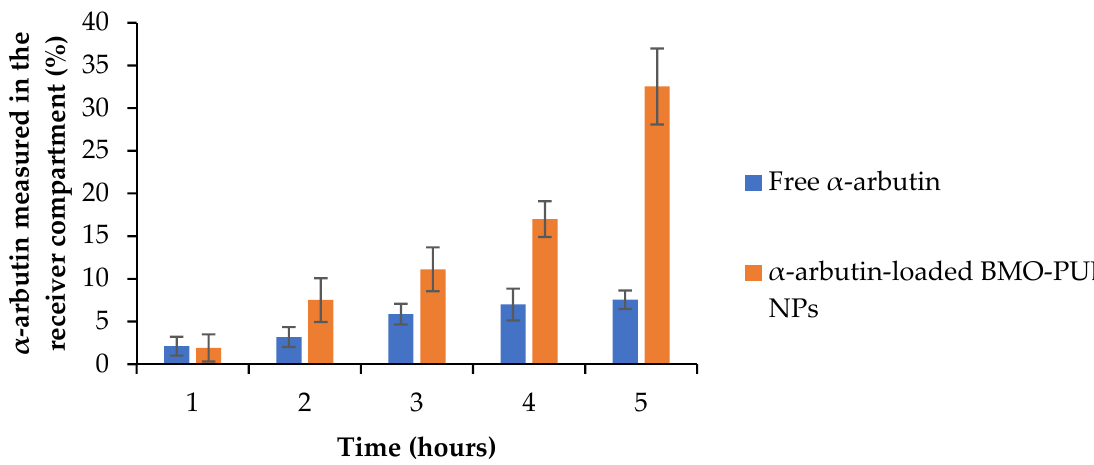
Figure 13. α -arbutin translocation (either as free model active or loaded within BMO-PUL NPs) across HaCaT cell monolayers ( n = 5, ± SD).